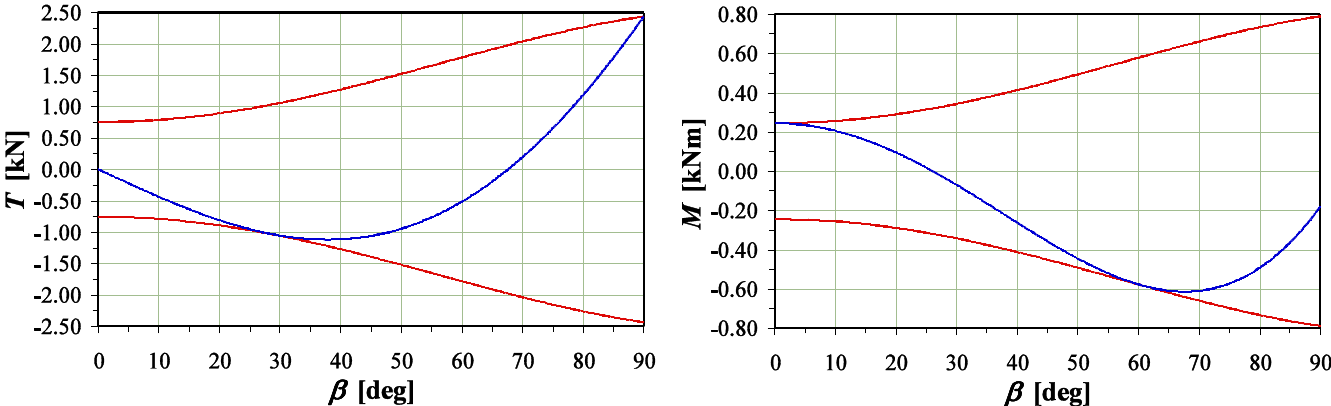
Figure 6: Numerical optimisation results for the trends of shear T (  ) and moment M (  ) at friction coefficient  =